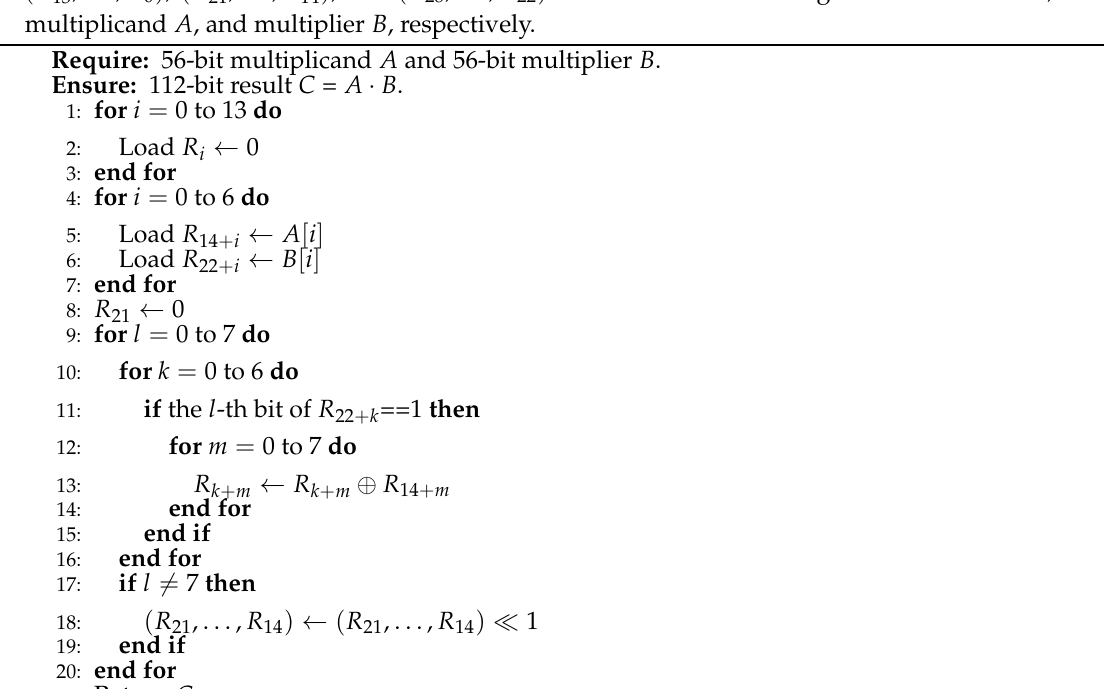
Algorithm A1: 56-bit wise Block-Comb multiplication method on ATmega128 microprocessor. ( R ) , ( R ) , and ( R ) are reserved for holding the accumulator C , 28 , . . . , R 22 13 , . . . , R 0 21 , . . . , R 14 multiplicand A , and multiplier B ,